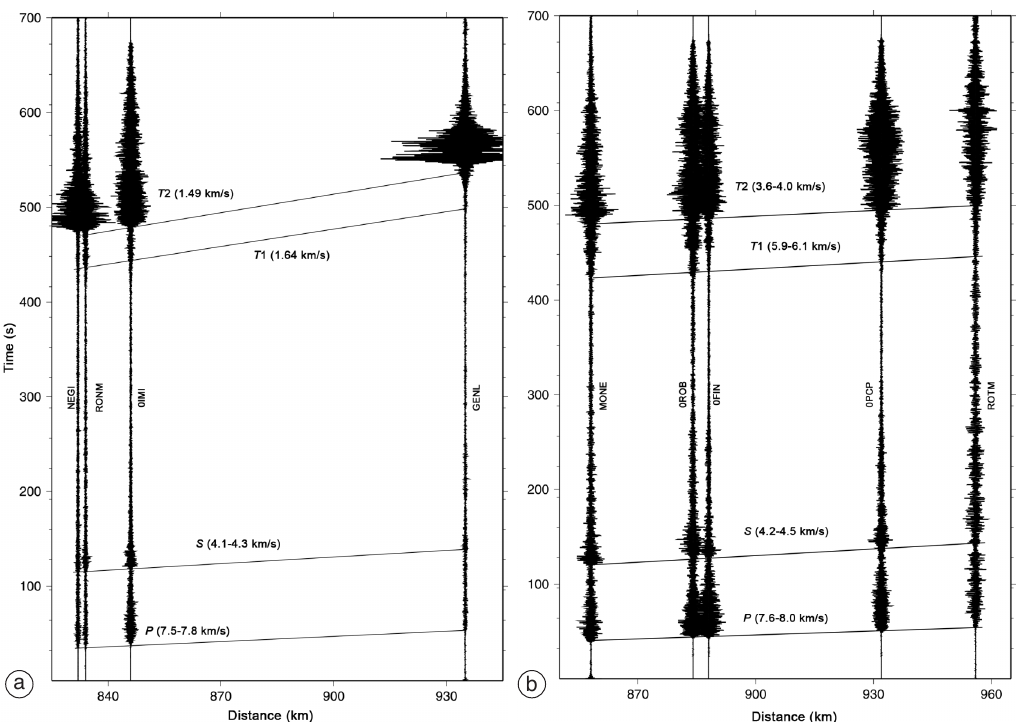
Fig. 6a,b. Seismograms of two groups (divided according to their location) of vertical components for stations ordered with respect to the epicentral distance: a) stations on the coast; b) stations in land. The recognized phas- es and their apparent velocities are also shown